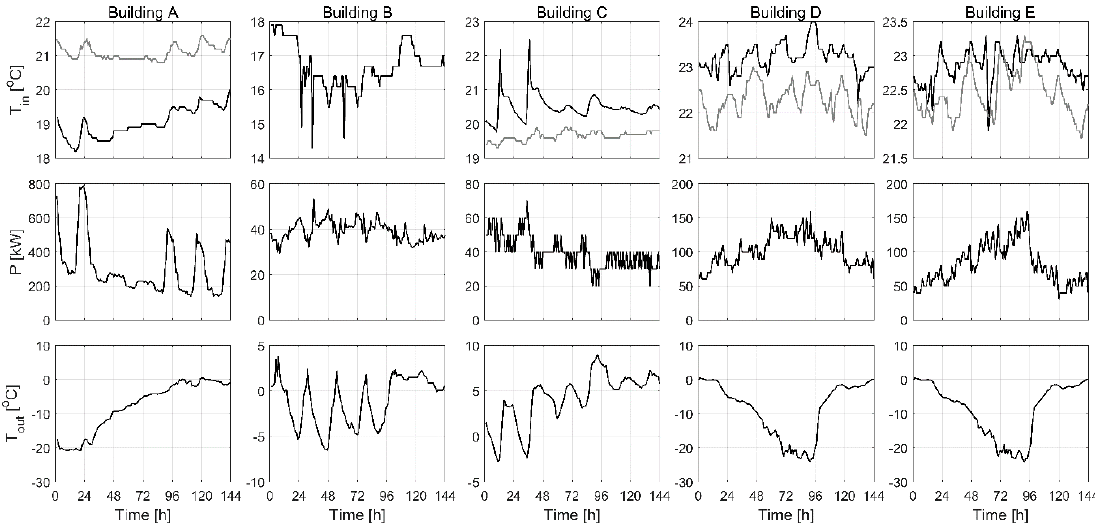
Figure 1. Measured indoor temperature ( T in ), heating power ( P ) and outdoor temperature ( T out ) for the five different buildings. Two measurements from different locations are presented (one in black and the other in grey) for indoor temperature except for building B where only one measurement was available.